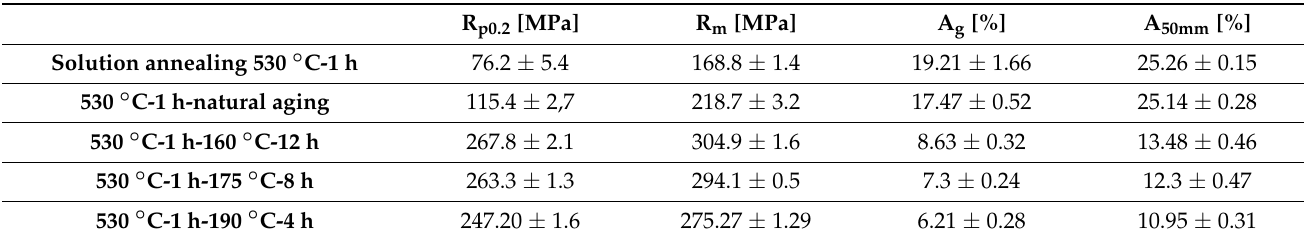
Table 4. Mechanical properties of alloy AW 6061 after heat treatment.